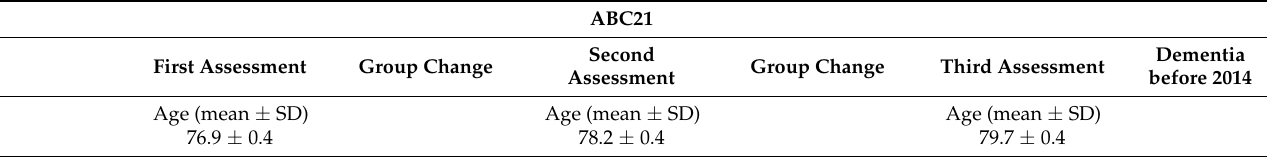
Table 4. Stability among MCI classifications of “not MCI”, “amnestic MCI” and “non-amnestic MCI” from first to second and third assessments with final any cause dementia outcomes. “Losses to follow-up” were attributed to death, illness or withdrawal from the